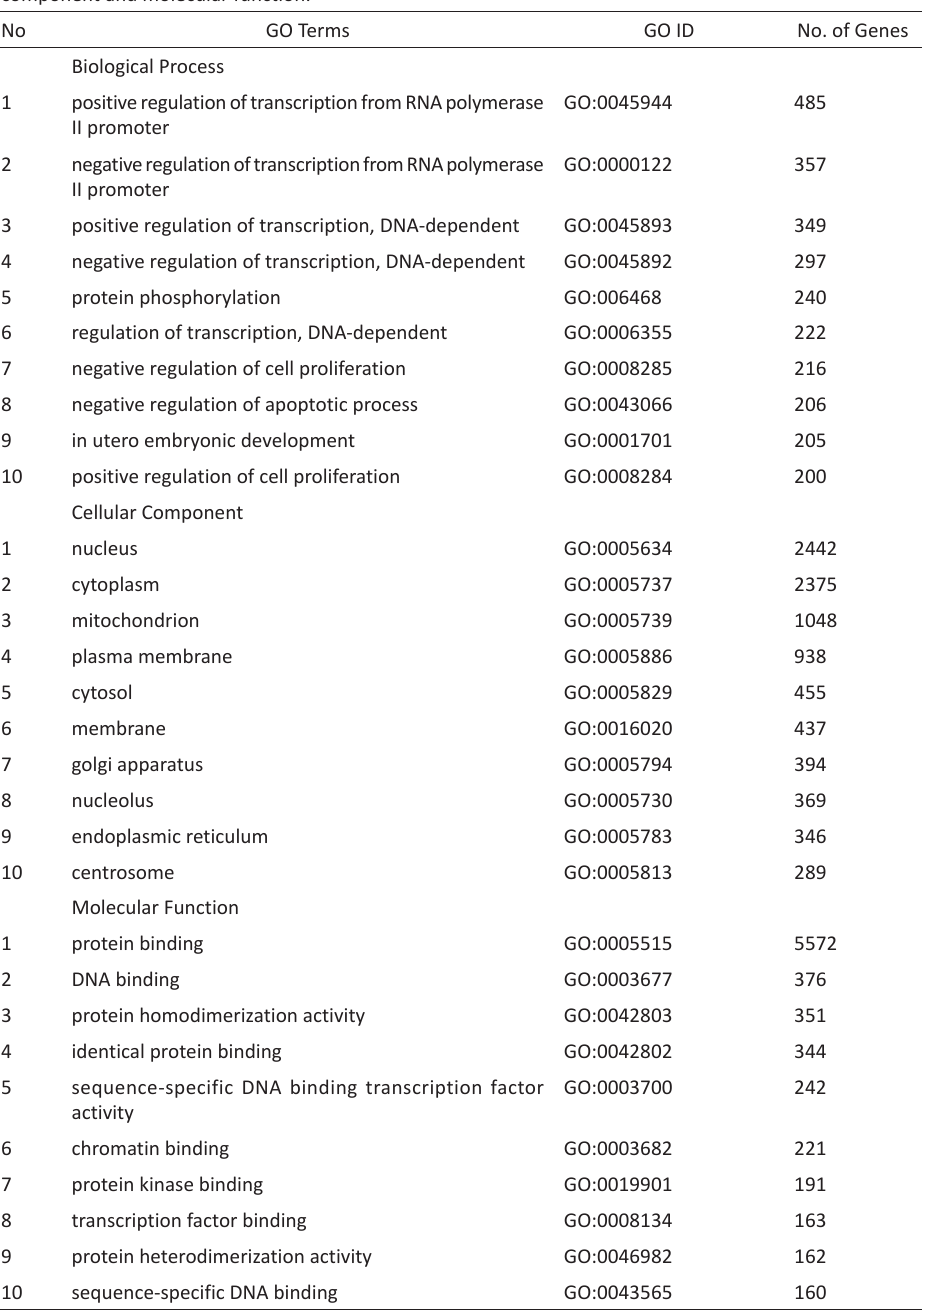
Table 1. Gene Ontology analysis. The table represents top ten GO terms for biological processes, cellular component and molecular